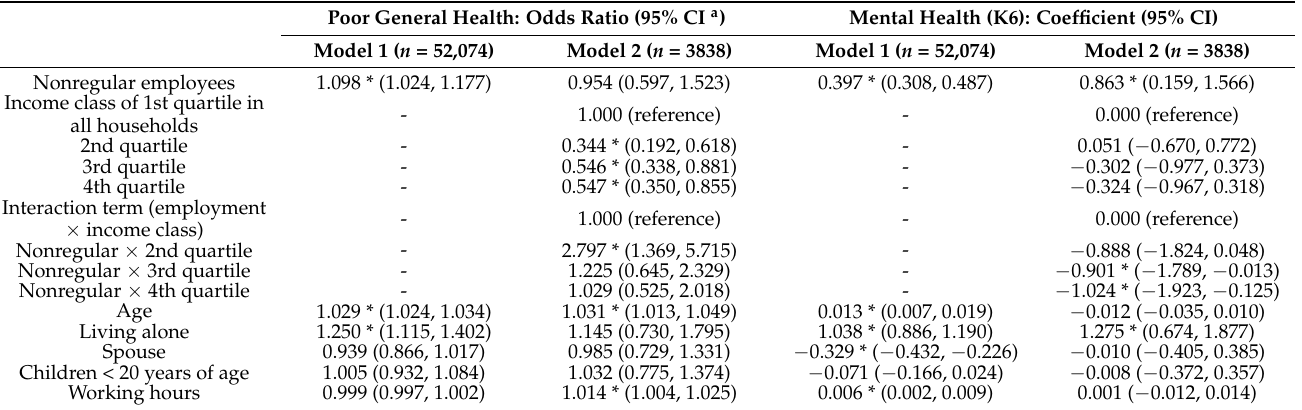
Table 4. Effect of employment, working conditions, and demographic characters on health indicators in the regression models for prediction among female